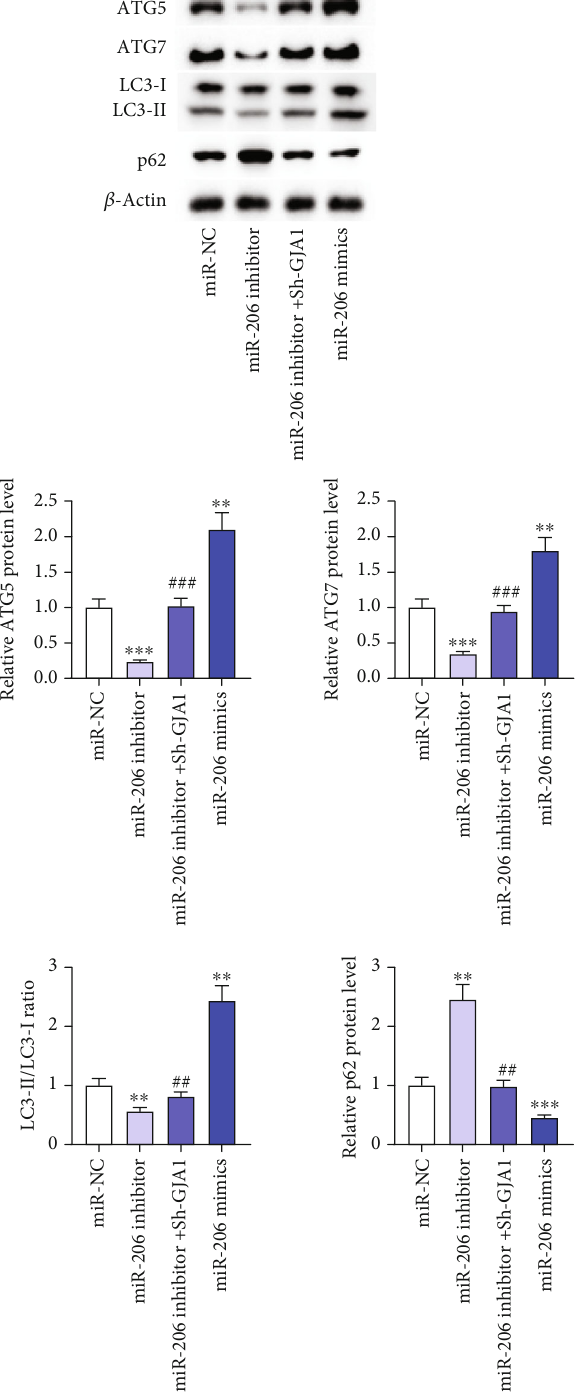
Figure 4: miR-206 modulates the autophagy of EPCs via targeting GJA1. (a) Western blotting analysis of levels of autophagy-related proteins in EPCs after miR-NC, miR-206 inhibitor, miR-206 inhibitor+sh-GJA1, or miR-206 mimic transfection. ∗∗ p < 0 : 01 and ∗∗∗ p < 0 : 001 versus miR-NC; ## p < 0 : 01 and ### p < 0 : 001 versus miR-206